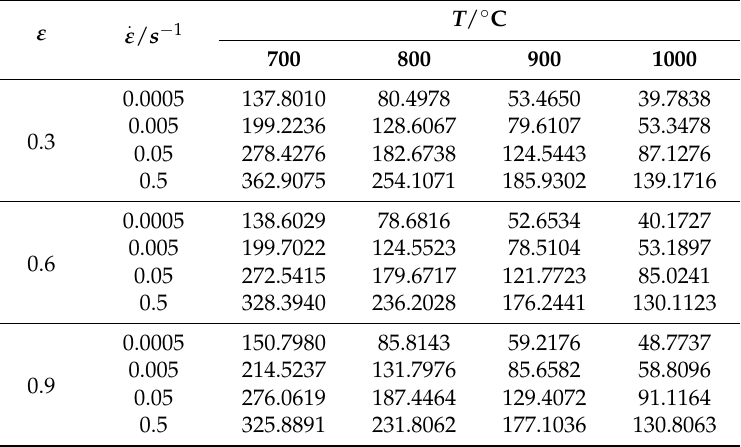
. . . ε = 0.0005 s − 1 ; ( b ) ε = 0.005 s − 1 ; ( c ) ε = 0.05 s − 1 ; and ( d ) Table 1. Flow stresses of NiTiNb SMA Table 1. Flow stresses of NiTiNb SMA (MPa).